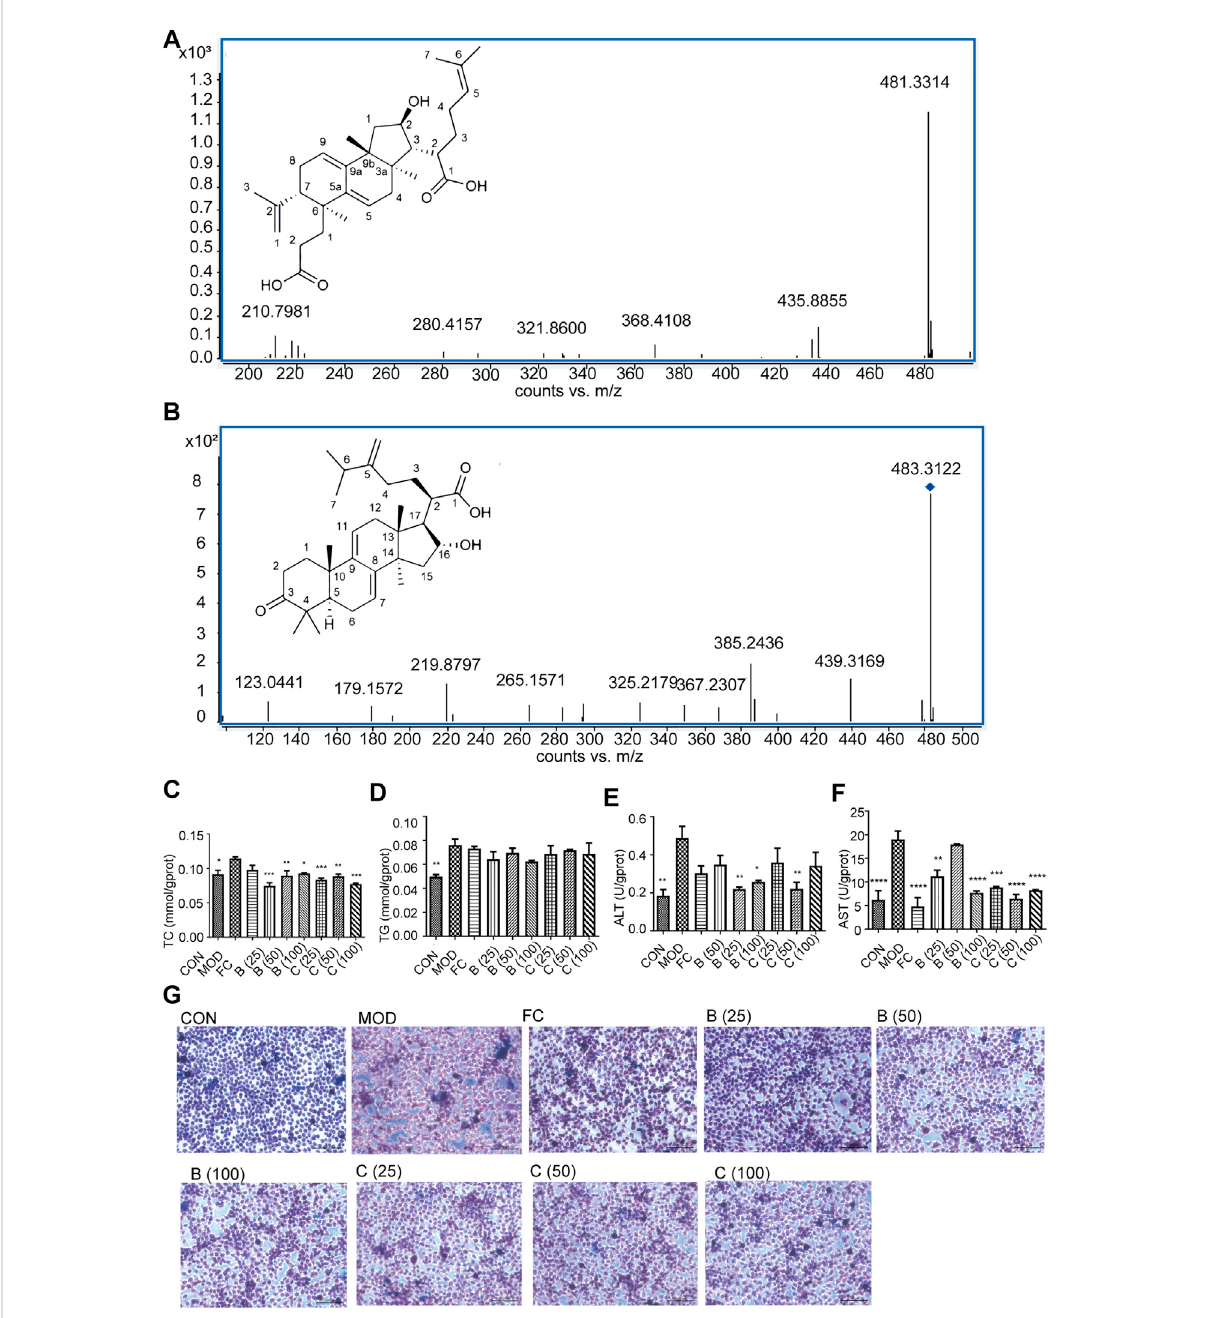
Identi fi cation of poricoic acid B and polyporenic acid C. (A) Characteristic ion peak and 2D structure of poricoic acid B. (B) Characteristic ion peak and 2D structure of polyporenic acid C. (C-F) Cell levels of TC, TG, ALT, AST. (G) Fat accumulation in cells were evaluated under a light microscope (×200) after Oil Red O staining dose (25, 50, and 100 μ mol/L) of poricoic acid B group (B (25), B (50), and B (100)), dose (25, 50, and 100 μ mol/L) of polyporenic acid C group (C (25), B (50), and B (100)), and FC (150 μ mol/L) or separate medium (CON group). n = 3, data are presented as mean ± SEM. One-way analysis of variance (ANOVA) was conducted for the group comparison. * p < 0.05, ** p < 0.01, *** p < 0.001, **** p < 0.0001 vs